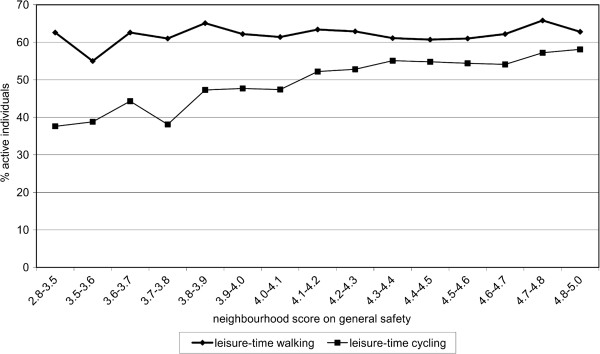
Weighted percentage of individuals engaging in leisure-time walking or cycling for at least 30 minutes per week, by level of general neighbourhood safety.